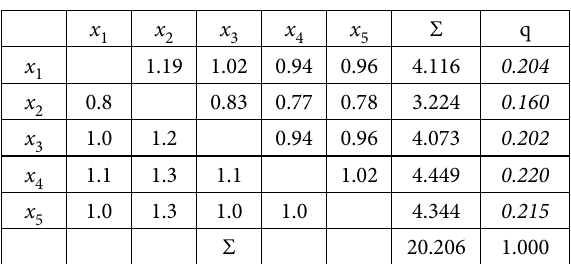
Table 2. The pairwise comparison of criteria